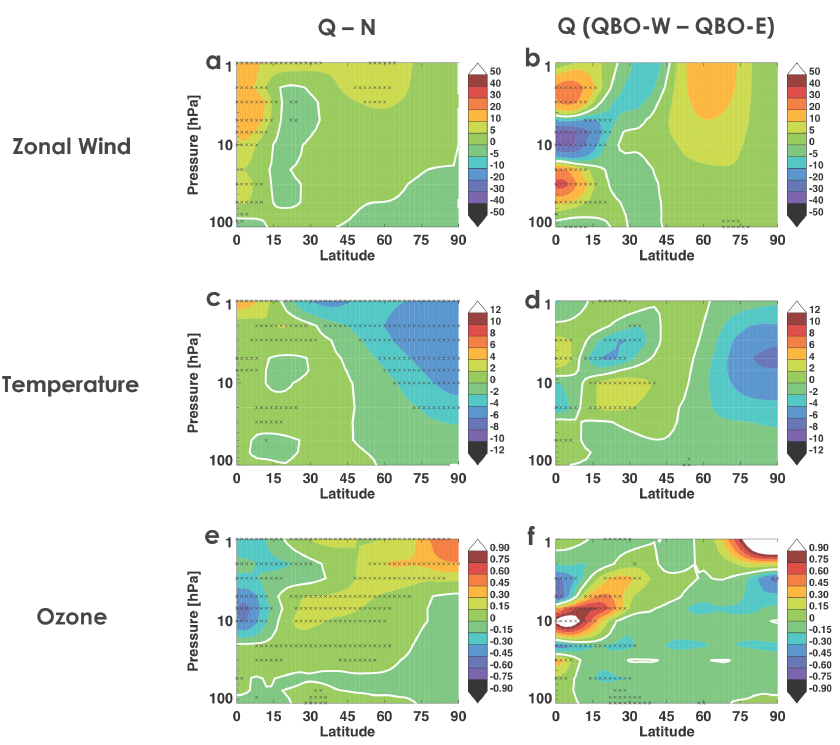
Figure 12 : January (a–b) zonal wind [m s -1 ], (c–d) temperature [K] and (e–f) ozone 556 Fig. 12. January (a–b) zonal wind (ms − 1 ), (c–d) temperature (K) and (e–f) ozone (ppmv) differences in the Northern Hemisphere. (a, c, e) Q − N mean differences; (b, d, f) QBO-westerly − QBO-easterly differences in the Q simulation. White contours indicate zero difference. [ppmv] differences in the Northern Hemisphere. (a, c, e) Q – N mean differences; (b, d, 557 Black Xs indicate differences significant at the 95% level in a two-trailed t f) QBO–westerly – QBO–easterly differences in the Q simulation. White contours 558 indicate zero difference. Black Xs indicate differences significant at the 95% level in a 559 two–tailed t–test. 560